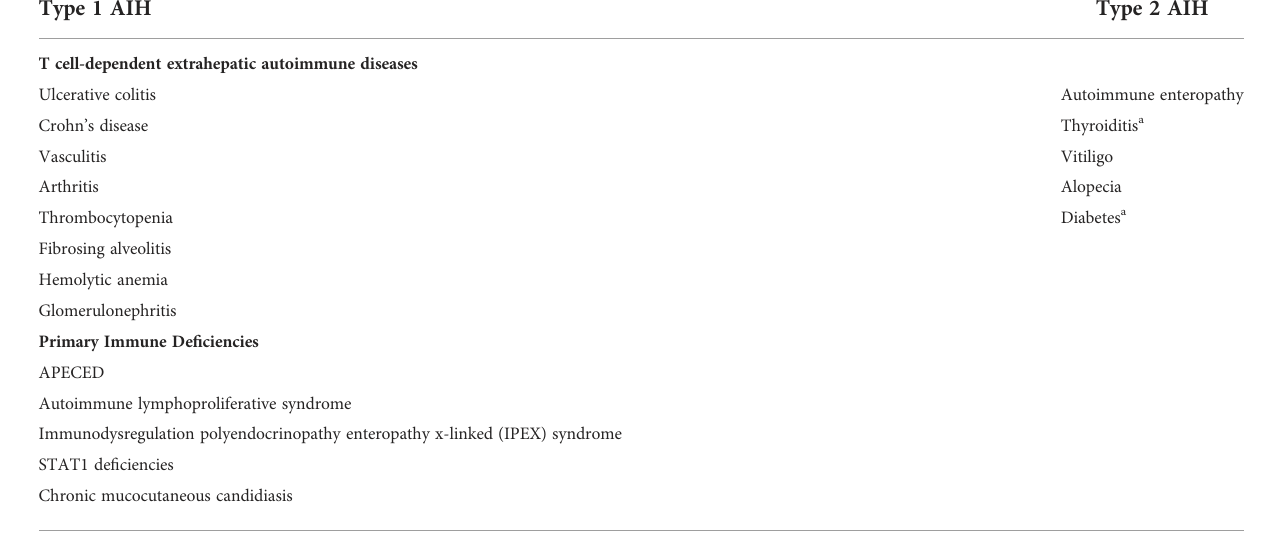
TABLE 1 Extrahepatic autoimmune diseases and Primary Immune de fi ciencies most frequently found in children with type 1 and 2 autoimmune hepatitis. Type 1